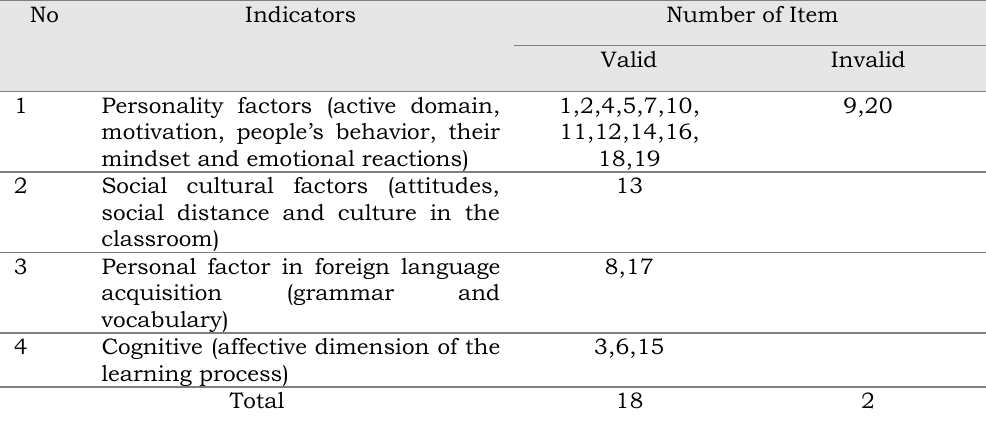
Table 2. Validity of the questionnaire